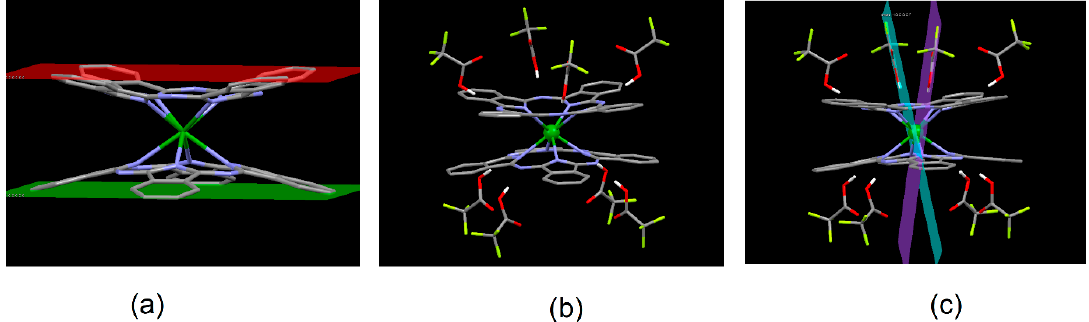
Figure 5. Calculated molecular structures: ( a ) LuPc 2 featuring the virtual 8C b planes; ( b ) the LuPc 2 @TFA conjugate; ( c ) LuPc 2 @TFA featuring the torsion angle ( γ ) between the opposite TFA molecules.